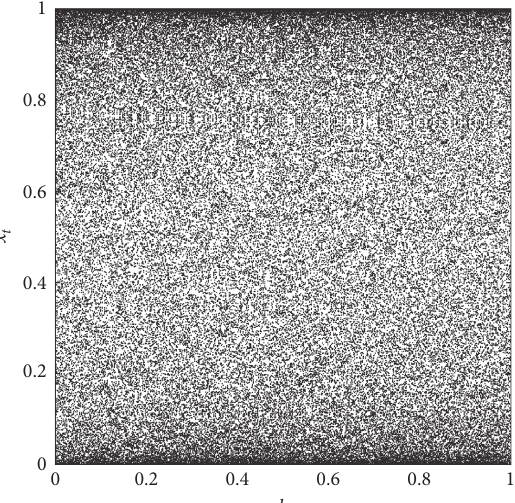
Figure 1: Bifurcation diagram of map equation (9) as a function of the parameter b .